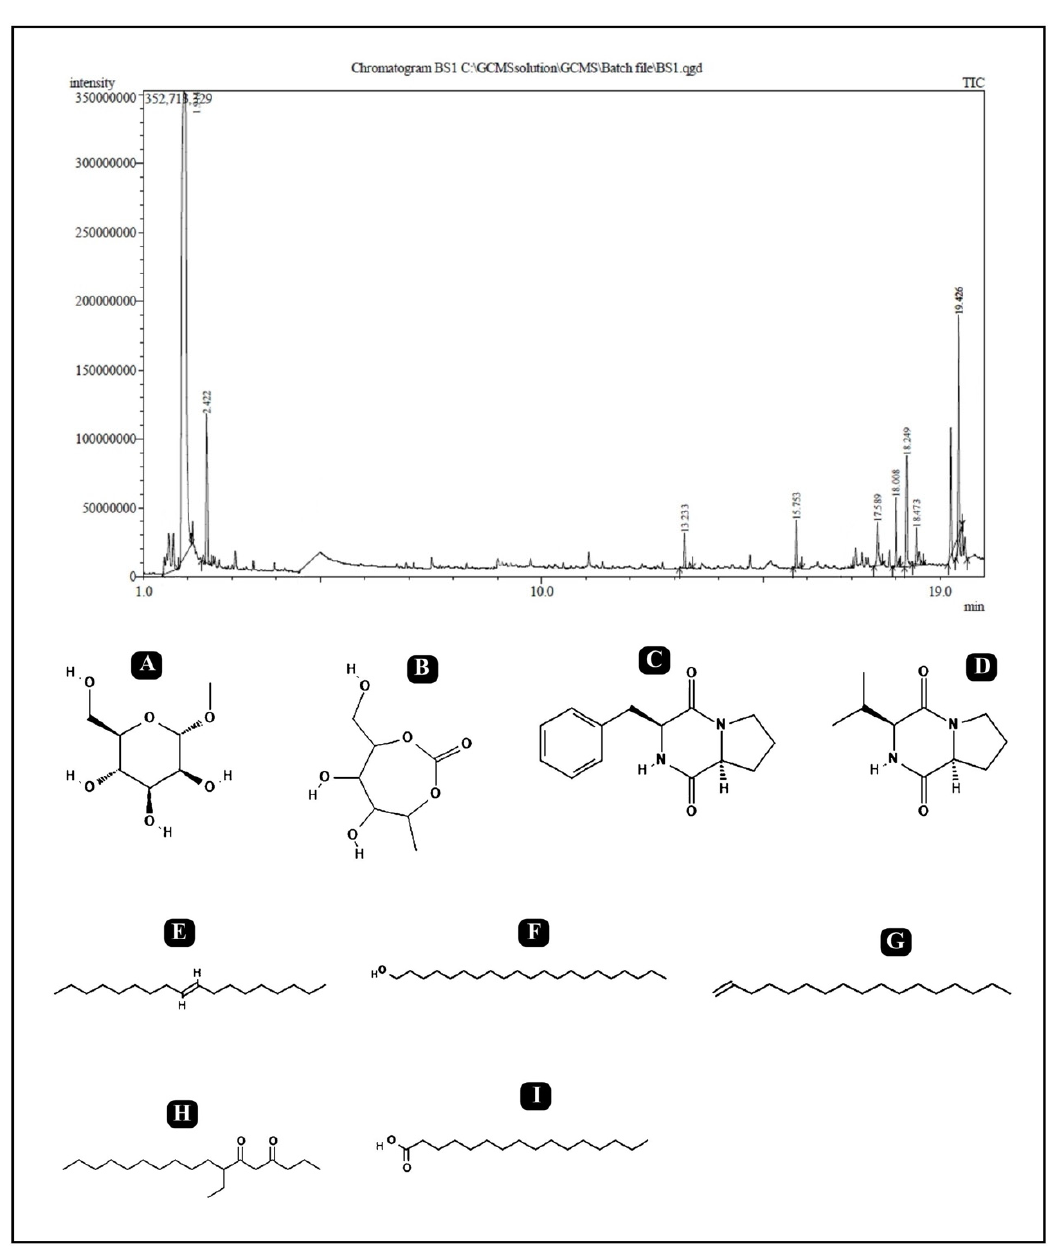
Figure 8. GC–MS analysis of the crude biosurfactants derived from L. rhamnosus. Identified compounds: ( A ) Isopropyl alpha-D-mannopyranoside; ( B ) 2,5-Monomethylene-l-rhamnitol; ( C ) (Cyclo(Phe-Pro)); ( D ) Cyclo(L-prolyl-L-valine); ( E ) 9- Octadecene; ( F ) 1-Heneicosanol; ( G ) 1-Heptadecene; ( H ) 7-Ethyl-4,6-heptadecandione; ( I ) n -Hexadecanoic acid. Table 3. Major constituents of the crude biosurfactants of L. rhamnosus using GC–MS. No.